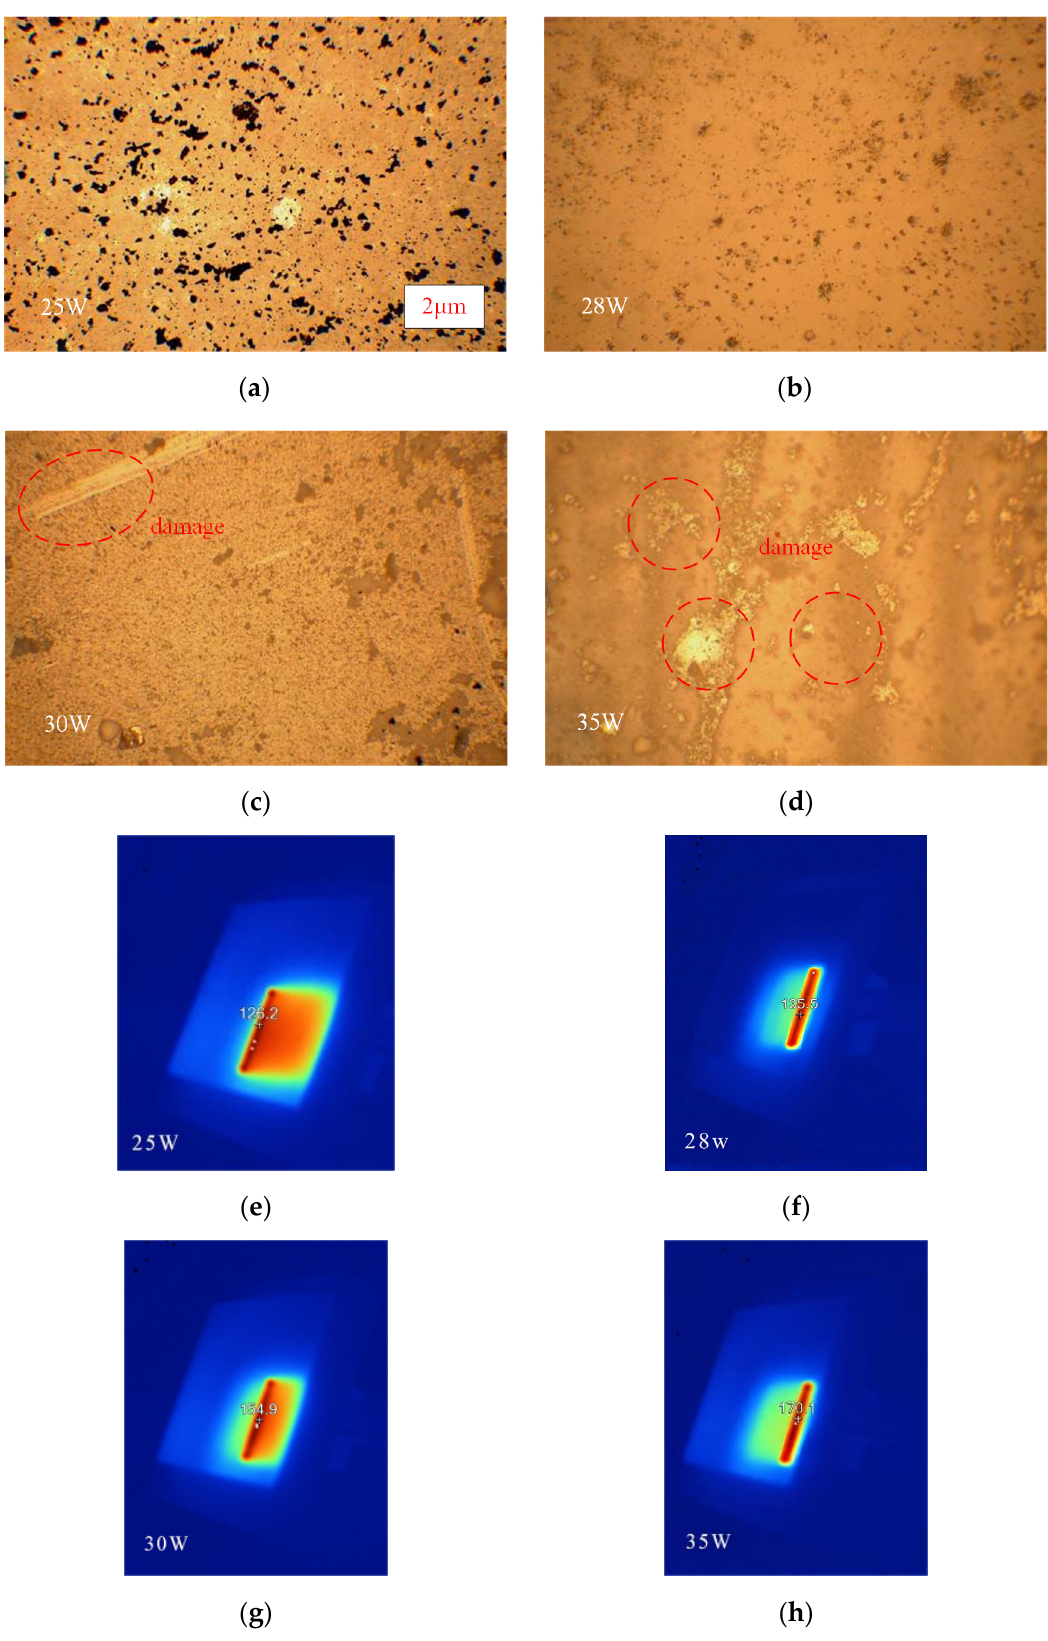
Figure 7. Cleaning e ff ect and Infrared temperature distribution with di ff erent powers: ( a ) 25 W; ( b ) 28 W; ( c ) 30 W; ( d ) 35 W; ( e ) 25 W; ( f ) 28 W; ( g ) 30 W; ( h ) 35 W.